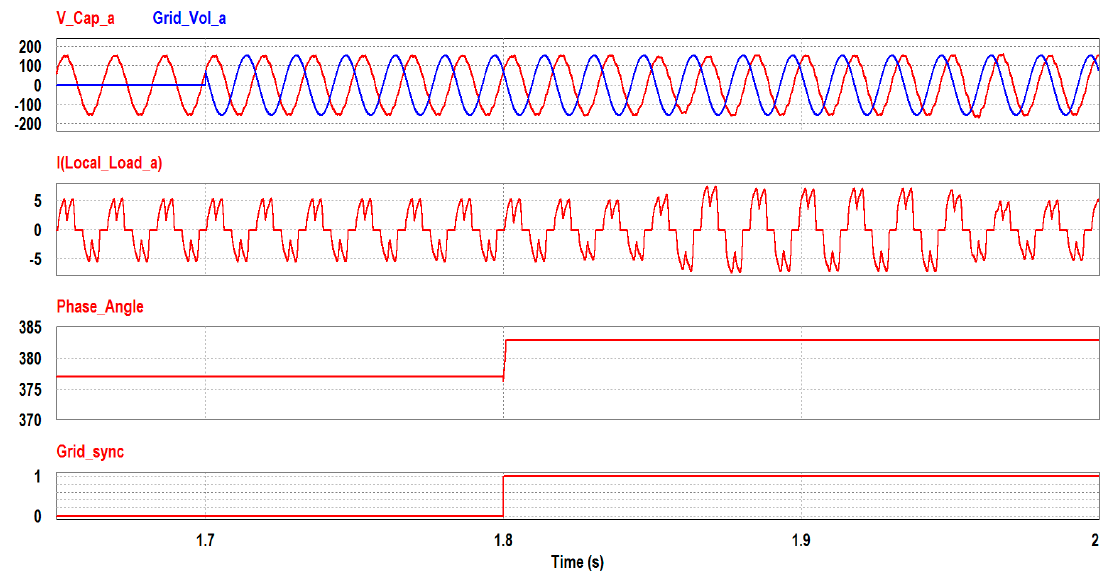
Figure 14. Simulation results in Case IV. (SBGS ⟶ GS Mode) (From top to bottom: Measured a -phase inverter output voltage and grid voltage, a -phase local load current, instantaneous angular frequency of output voltage, and GS status signal).